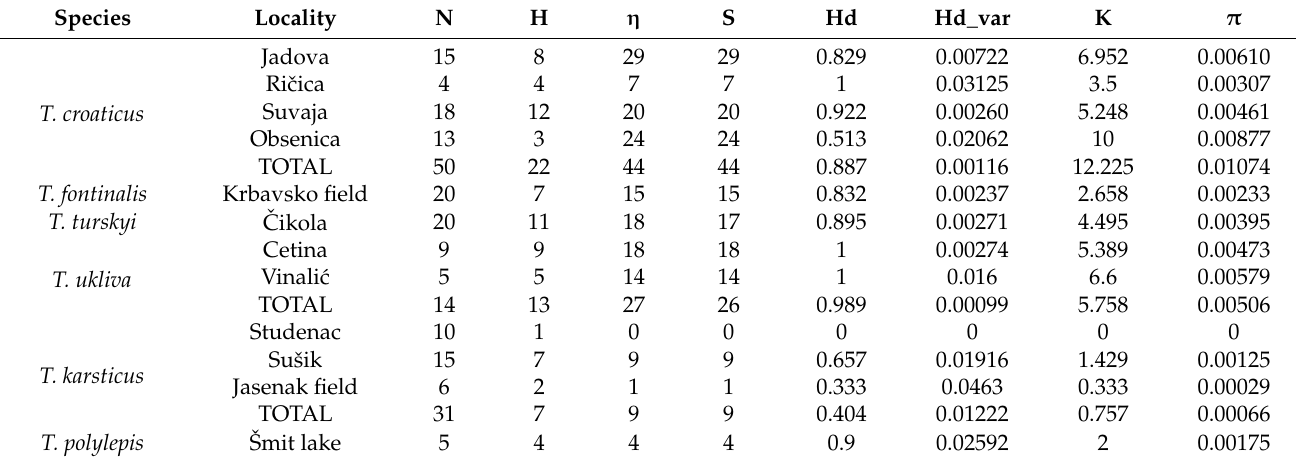
Table 2. Measures of intrapopulational genetic polymorphism estimated for populations of three endemic Telestes species. The remaining three species ( T. polylepis , T. fontinalis , and T. turskyi ) comprise a single population, so the intraspecific and intrapopulational genetic diversities are the same. N— number of sequences, S—number of polymorphic sites, η —total number of mutations, H—number of haplotypes, Hd—haplotype diversity, Hd_var—variance of haplotype diversity, K—total number of nucleotide differences, π —nucleotide